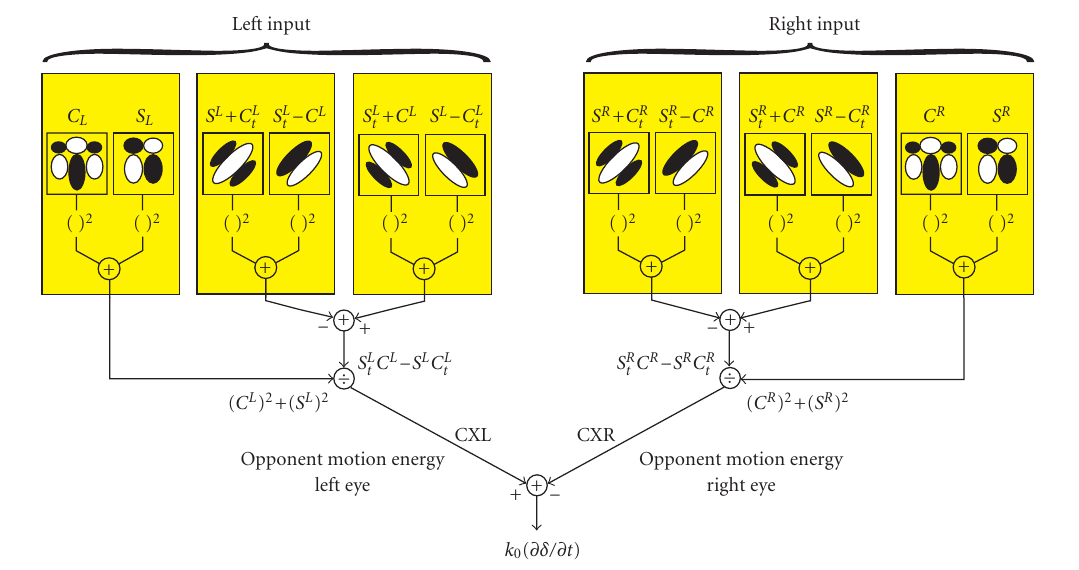
Figure 2: Cortical architecture of a MID detector. The rate of variation of disparity can be obtained by a direct comparison of the responses of two monocular units labelled CXL and CXR. Each monocular unit receives contributions from a pair of directionally tuned “energy” complex cells that compute phase temporal derivative ( S t C − SC t ) and a nondirectional complex cell that supplies the “static” energy of the stimulus ( C 2 + S 2 ). Each monocular branch of the cortical architecture can be directly compared to the Adelson-Bergen motion detector, thus establishing a link between phase-based approaches and motion energy